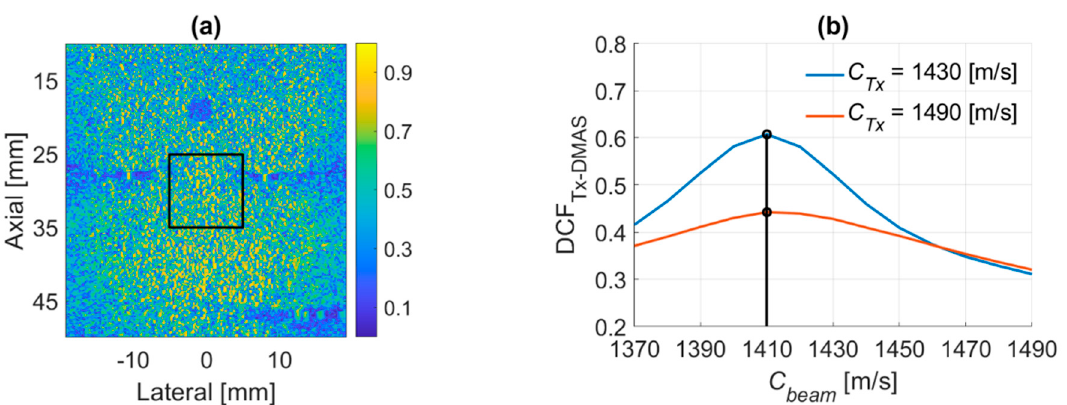
Figure 13. ( a ) DCF map of Tx-DMAS beamforming for the supplementary dataset to test the effect of mismatch between C TX and tissue SOS. ( b ) Plot of averaged DCF value in ( a ) as a function of C beam for different C TX .